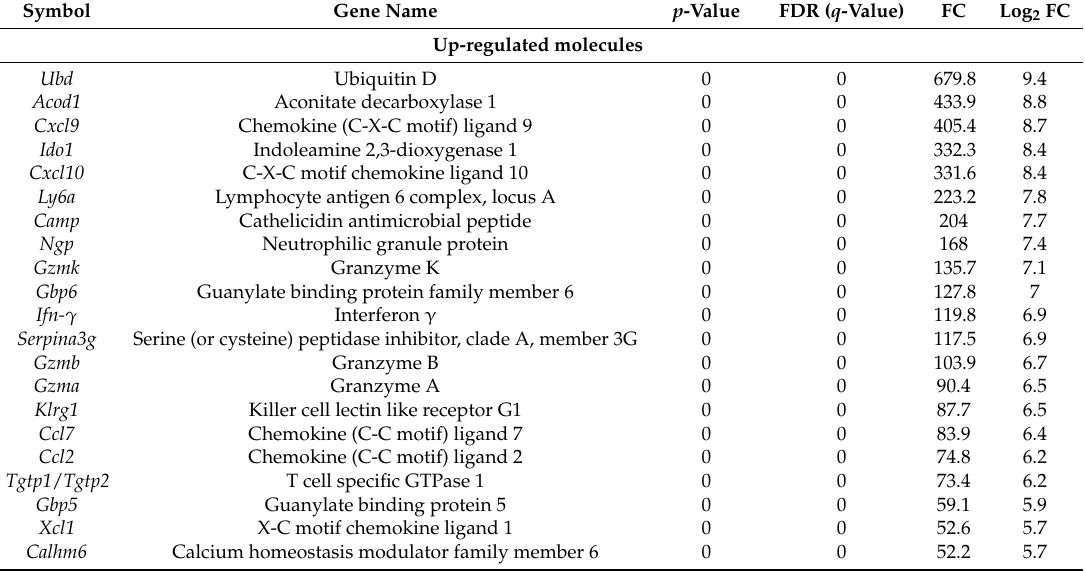
Table 1. List of the top 20 up- and down-regulated molecules in mouse lung tissue during in vivo R. conorii